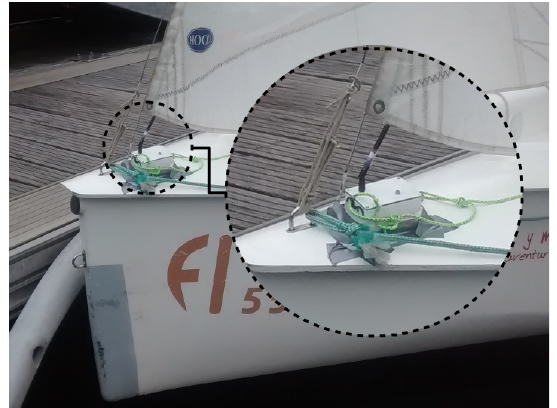
Figure 5. Tracking module on-board a participant